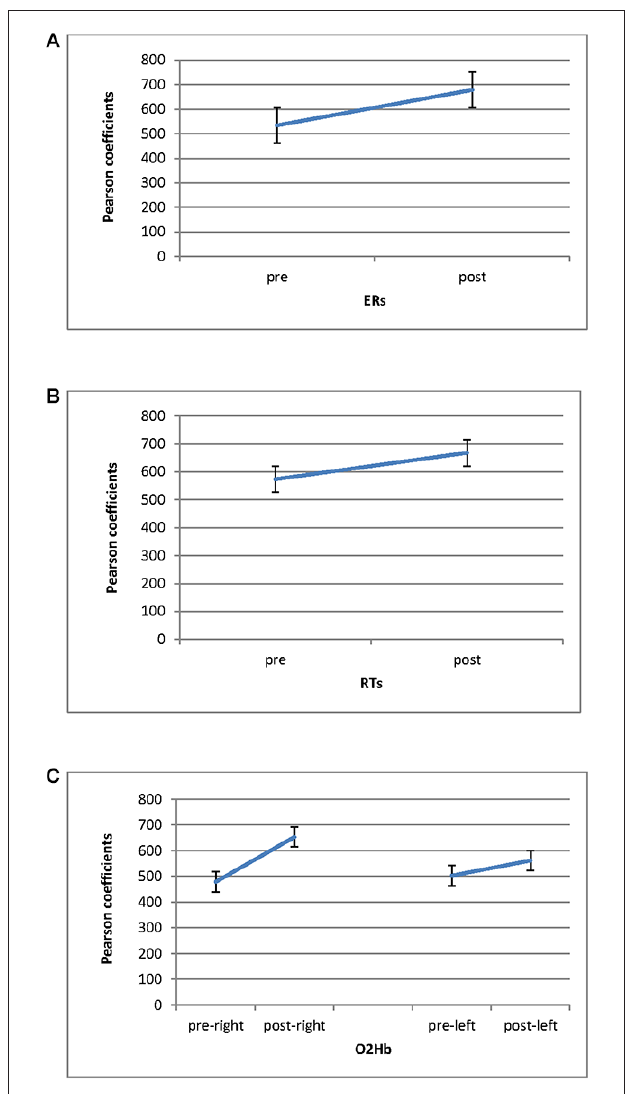
FIGURE 5 | Pearson coefficients as a function of pre-feedback and post-feedback for (A) ERs; (B) RTs measures, with decreased ERs and RTs for post-feedback; (C) O2Hb. It was observed an increasing of O2Hb for post-feedback in the right hemisphere.